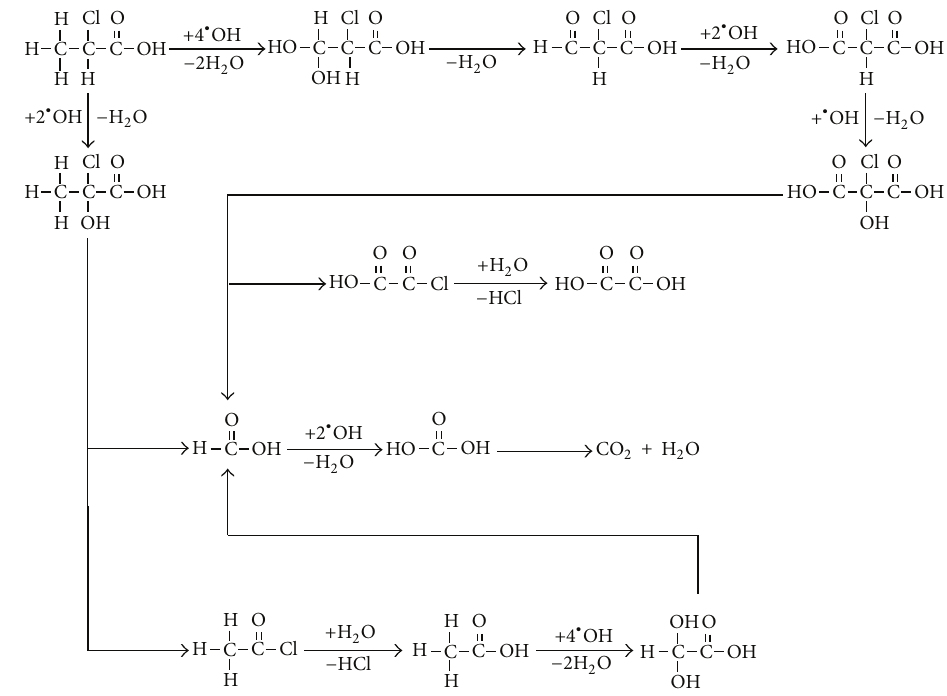
Scheme 2: Possible decomposition pathway for 2-MCPA by